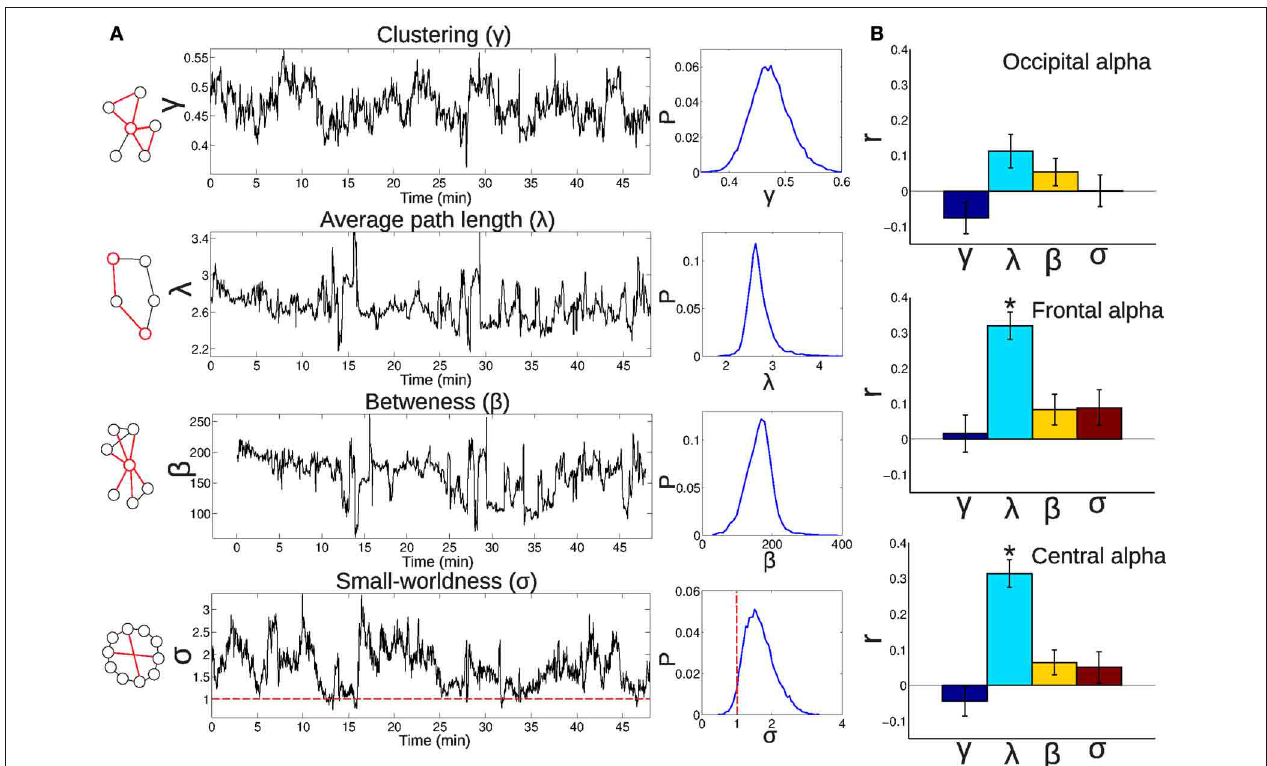
FIGURE 10 | (A) Left: Illustrations exemplifying the meaning of common graph metrics (clustering coefficient, average path length, betweeness, and small-worldness; for a detailed explanation, see the “Materials and Methods” section). Center: Examples showing the temporal evolution of the graph